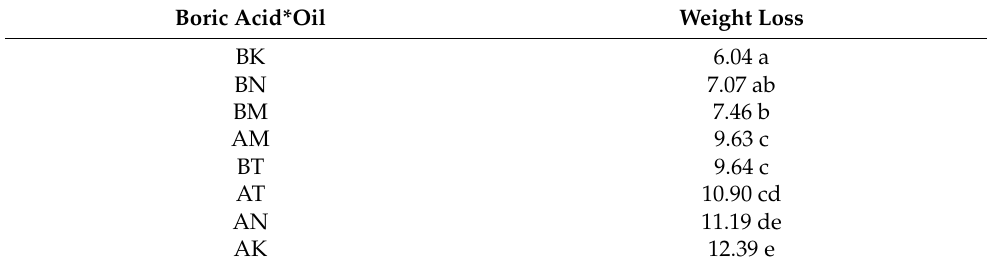
Table 9. Duncan test of weight loss due to decay